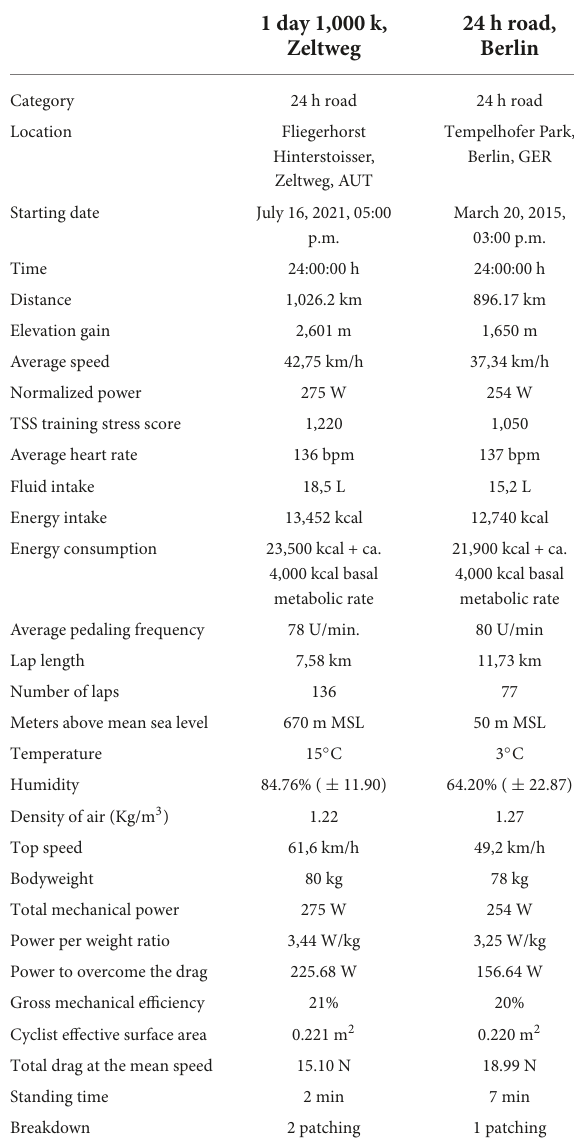
TABLE 1 Details (performance characteristics, energy expenditure, environmental conditions, altitude, temperature) of the three world